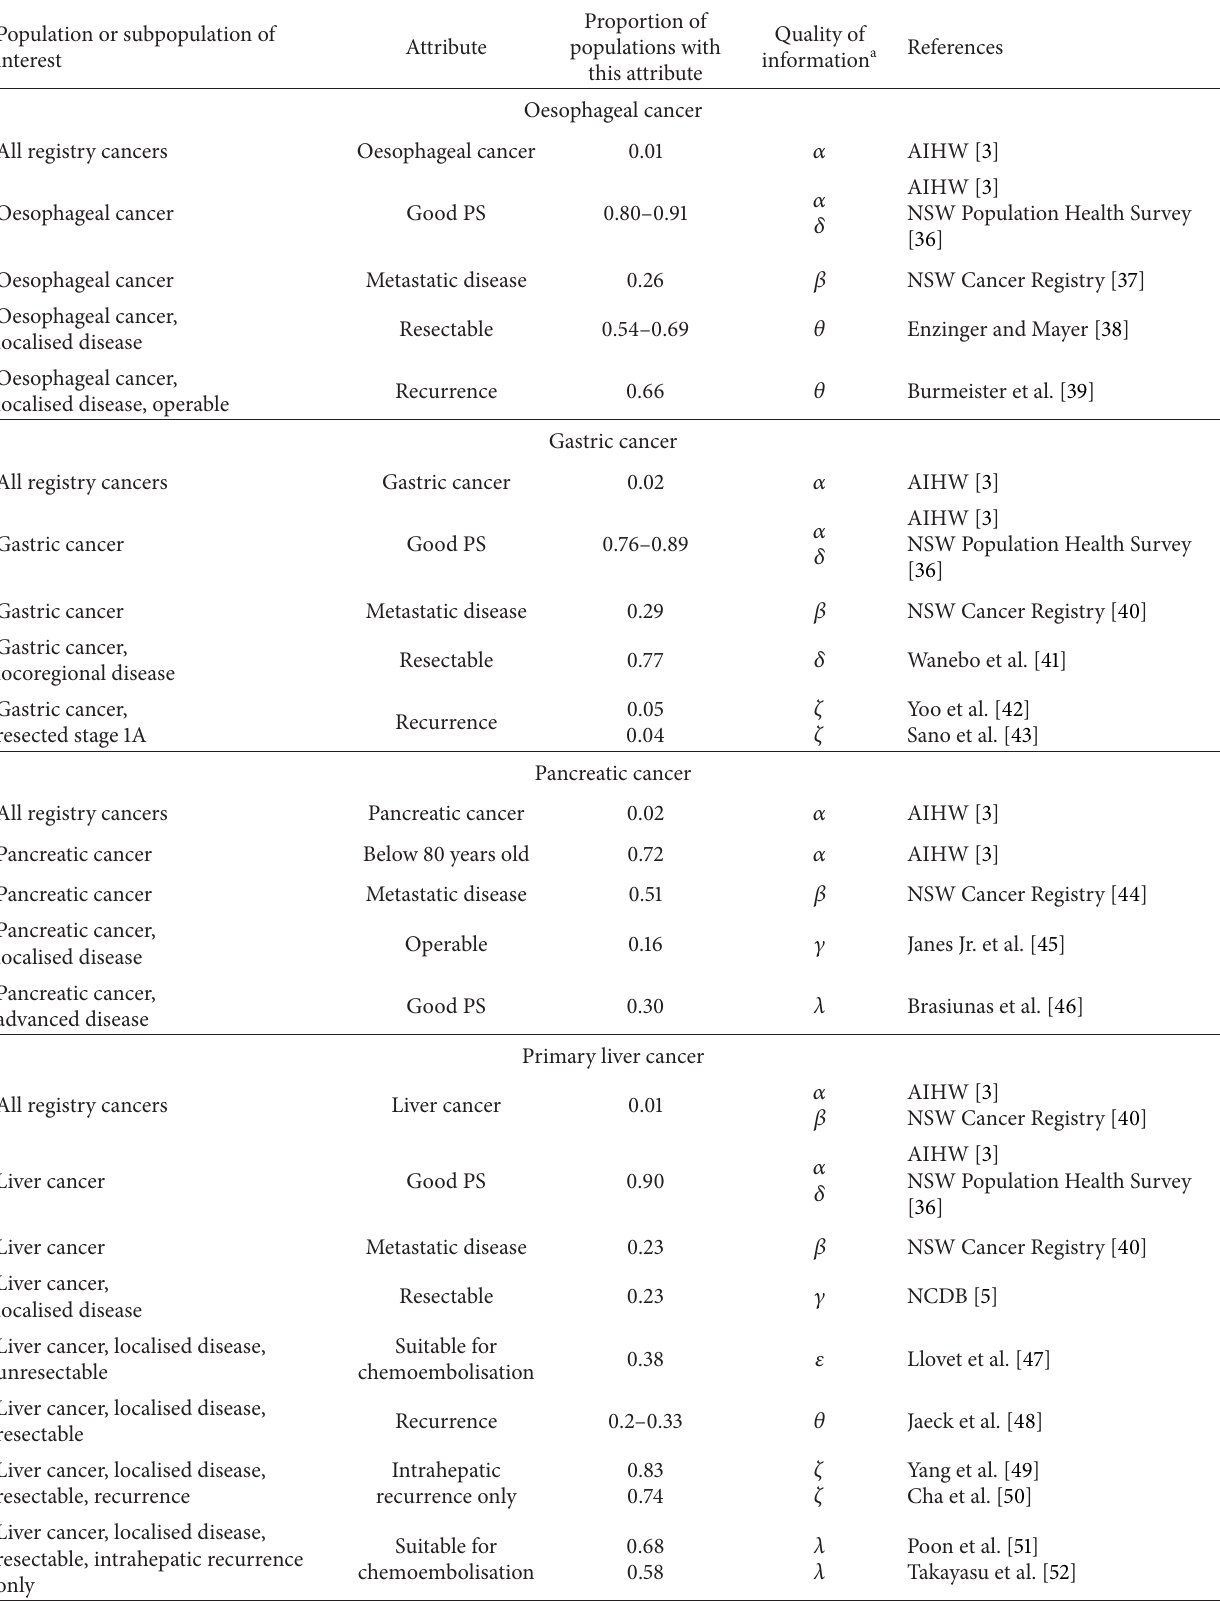
Table 2: The incidence of attributes used to define indications for